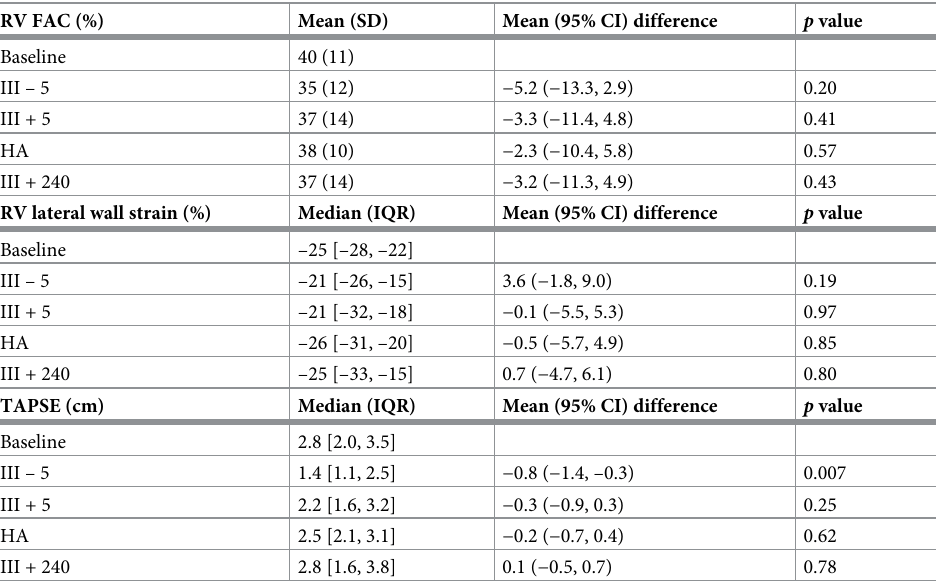
Table 2. Differences in echocardiographic metrics at each study time